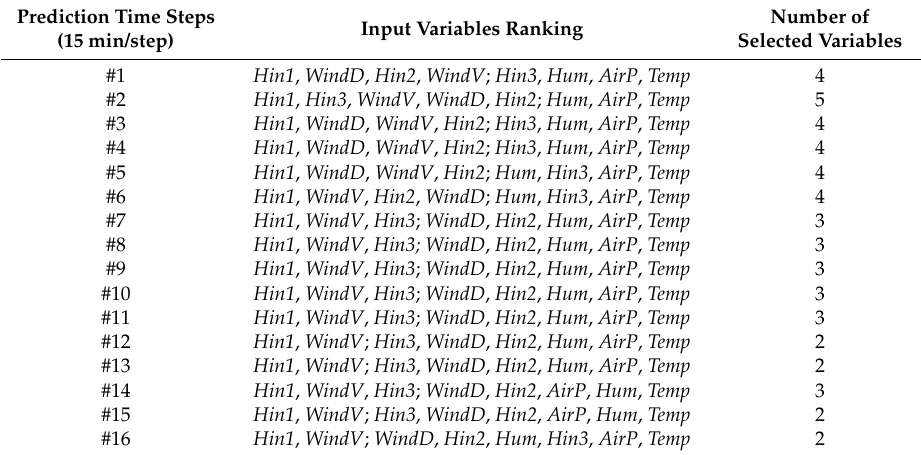
Table 1. Ranking and selection of candidate variables for Anzishan Farm.